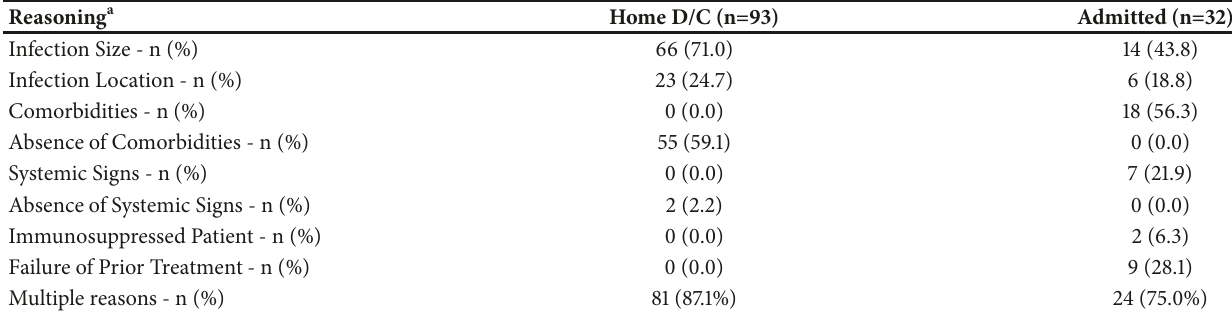
Table 4: Physician reasoning for disposition